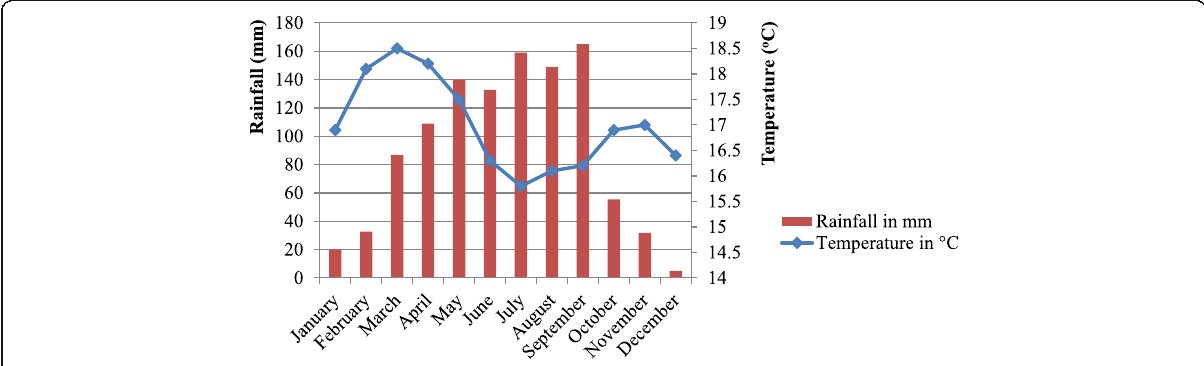
Fig. 2 Mean monthly rainfall and temperature of the of study